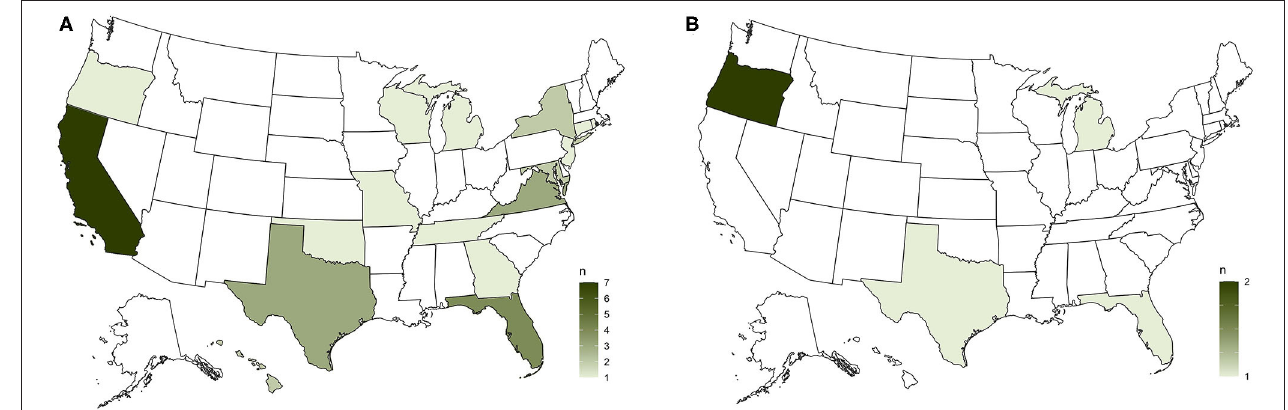
FIGURE 5 | (A) Similarly to our question about animal control authorities, public/overt conflict between feral cat advocates and wildlife and bird people was most reported from California. (B) Conversely, Oregon was the only state with more than one organization reporting feral cat advocates as engaged in active collaboration and working toward shared goals with wildlife and bird